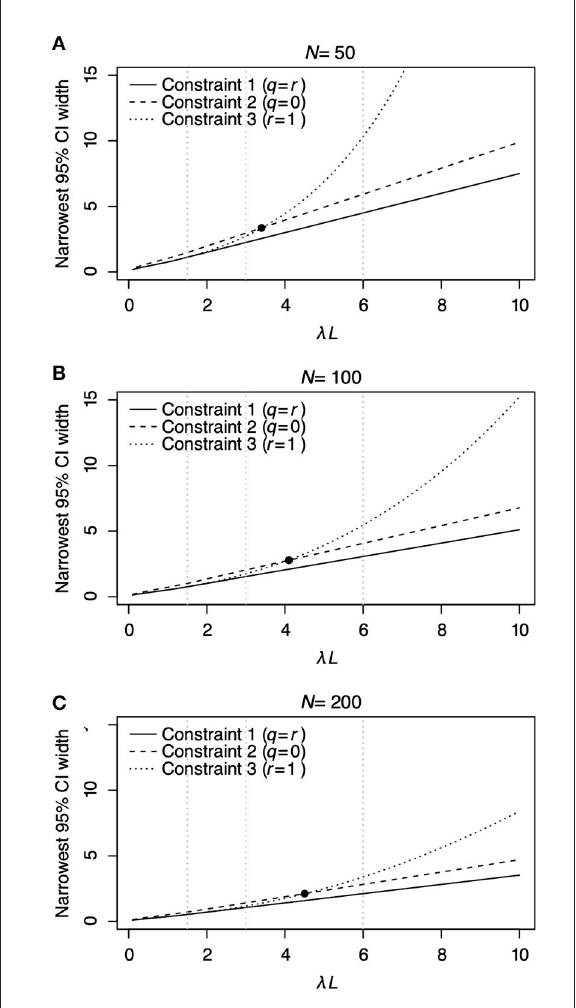
FIGURE3 The relationship between λ L and the narrowest 95% CI of λ L for each constraint is shown in Table 2 under different N = 50 (A) , N = 100 (B) , and N = 200 (C) . In each panel, the solid line represents Constraint 1, where q = r ; the dashed line represents Constraint 2, where q = 0; and the dotted line represents Constraint 3, where r = 1. The filled circles in (A–C) denote the point where the narrowest 95% CI of λ L under Constraints 2 and 3 has the same value. Vertical panel lines (A–C) are drawn at λ L = 1.5, λ L = 3.0, and λ L = 6.0, which are the values used in the surveillance simulations in Table